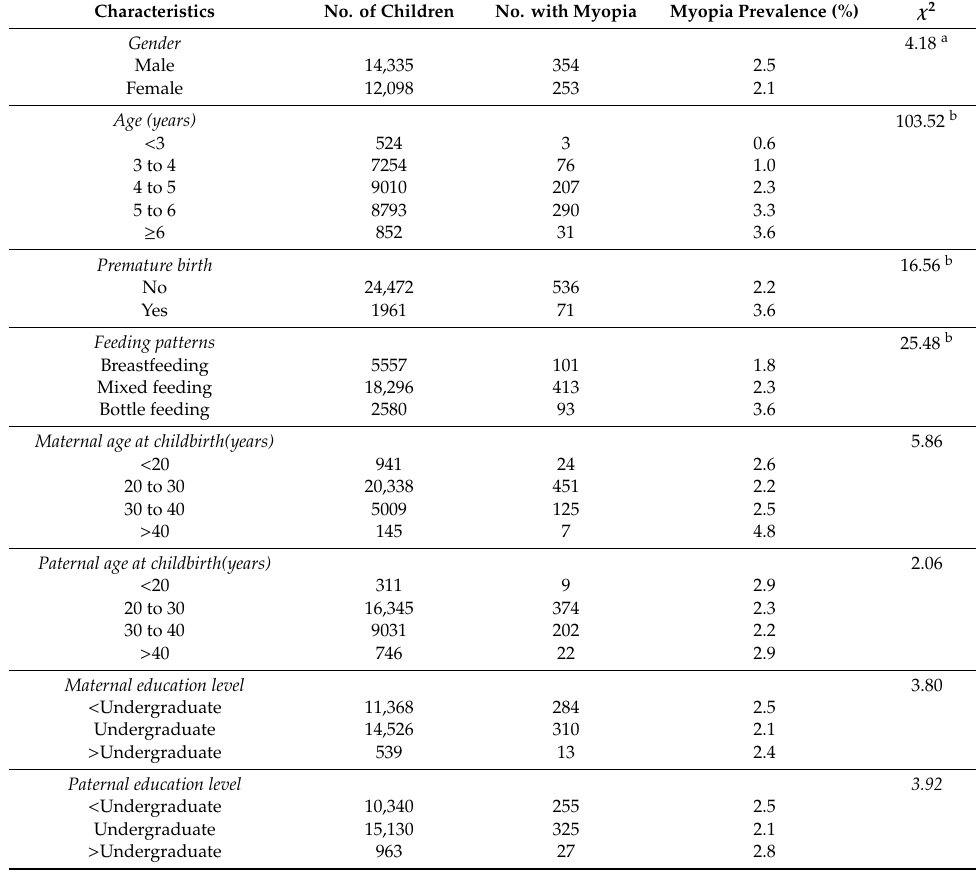
Table 1. Relationships between the reported characteristics of children and the presence of myopia.